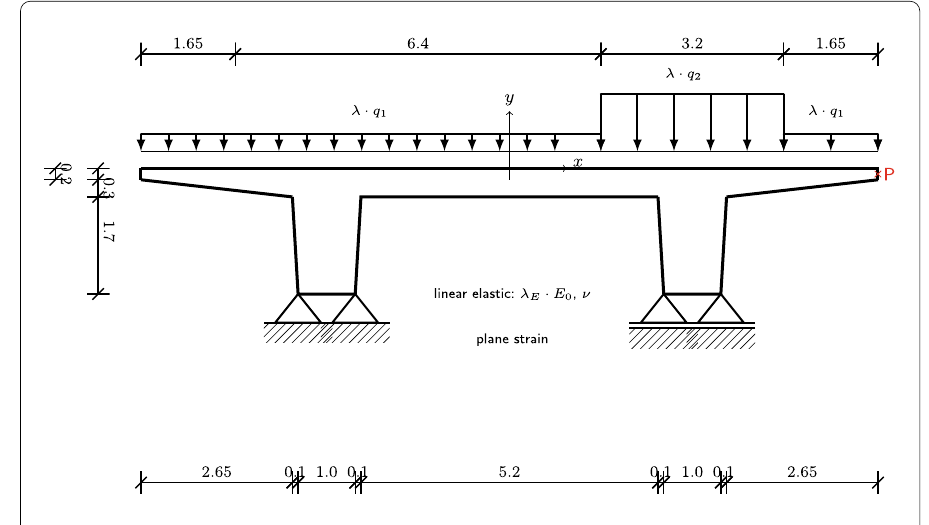
at the right end of the cross-section (point P at (6 . 45 , − 0 . 1)